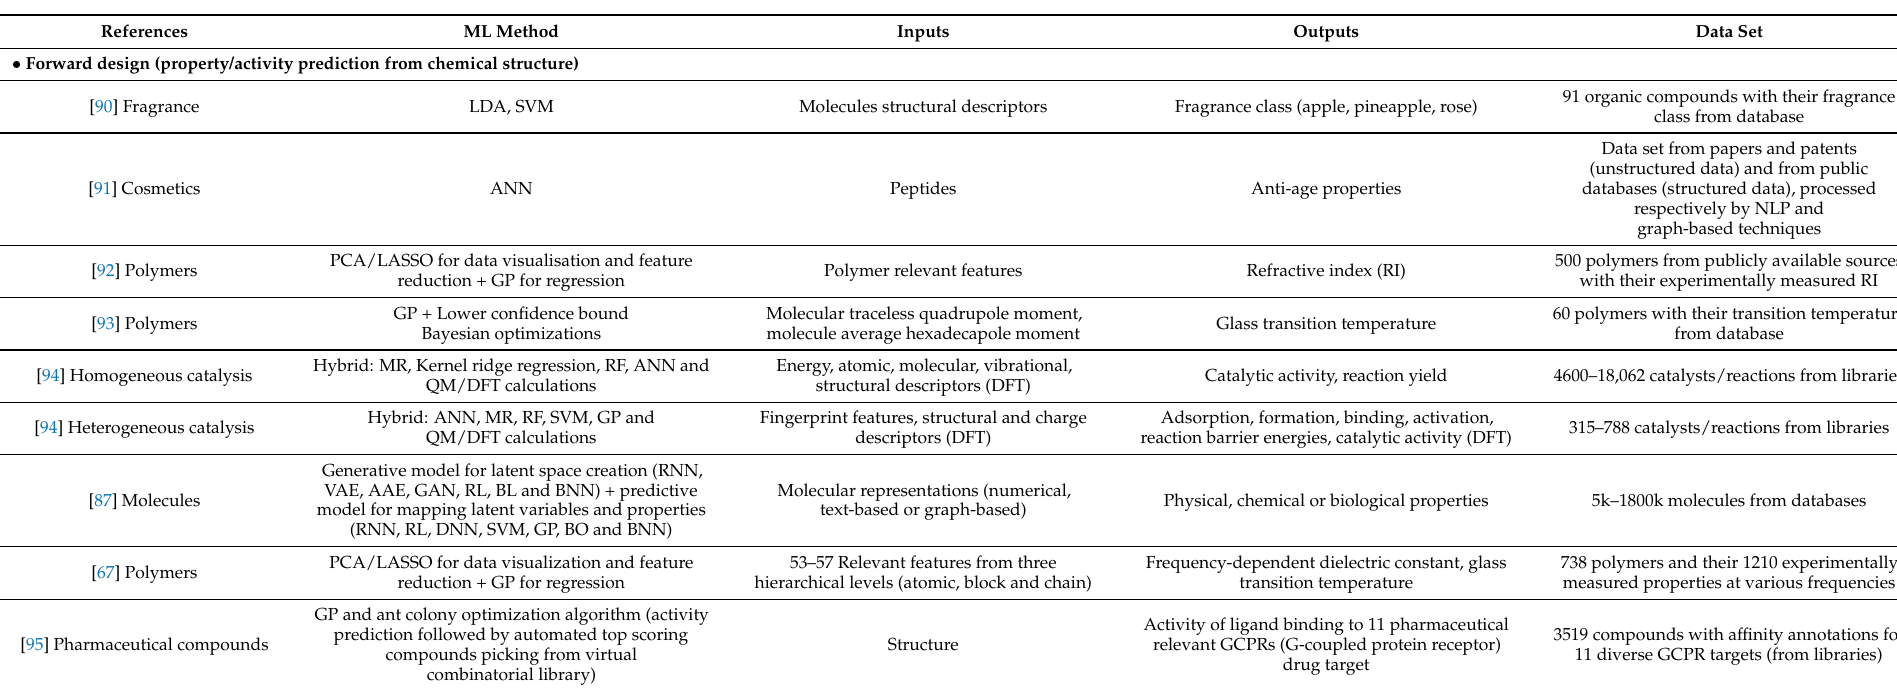
Table 3. Applications of ML in the design and discovery of molecules/materials. Acronyms: AAE: adversarial autoencoder, ANN: artificial neural network, BL: Bayesian learning, BNN: Bayesian neural network, BO: Bayesian optimization, COSMO-RS: conductor like screening model for real solvents, DFT: density functional theory, DNN: deep neural network, GAN: generative adversarial network, GP: Gaussian process, GCPR: G-coupled protein receptor, LASSO: least absolute shrinkage and selection operator, LDA: linear discriminant analysis, MR: multivariate regression, NLP: natural language processing, PCA: principal component analysis, QM: quantum mechanics, RI: refractive index, RF: random forest, RL: reinforcement learning, RNN: recurrent neural network, SMILES: simplified molecular input line entry specification, SVM: support vector machine, and VAE: variational